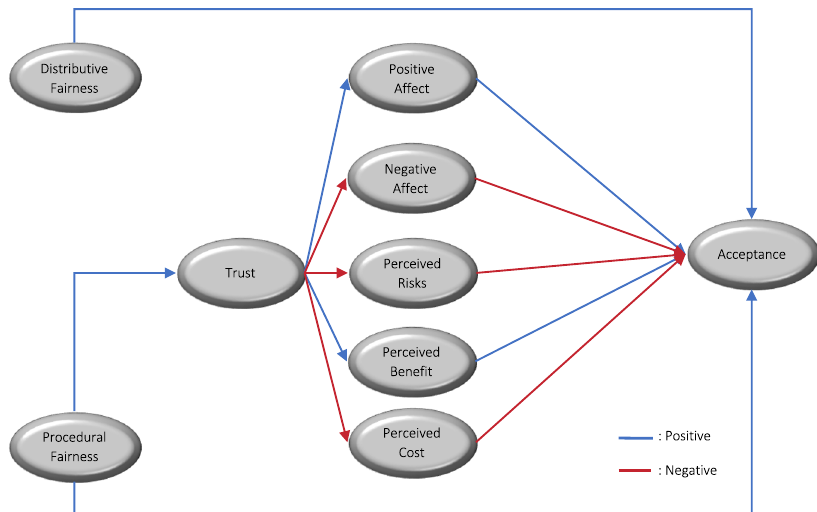
Fig. 3 Structural model results for the social acceptance of Tisza River Bank in Szeged, Hungary. Insigni fi cant variables are dropped from the theoretical model. Arrows represent the direction of causality between the latent variables. The red and blue arrows represent negative and positive associations,